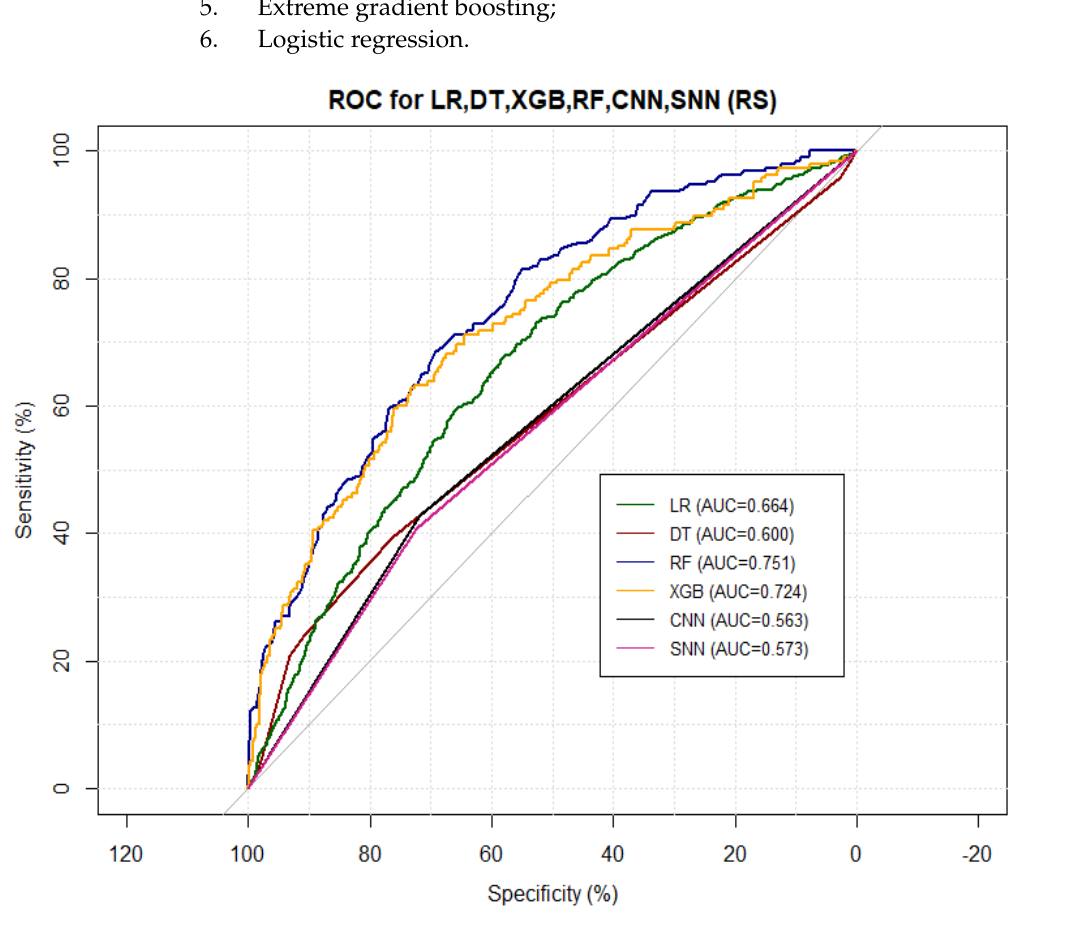
Figure 19. Combined ROC